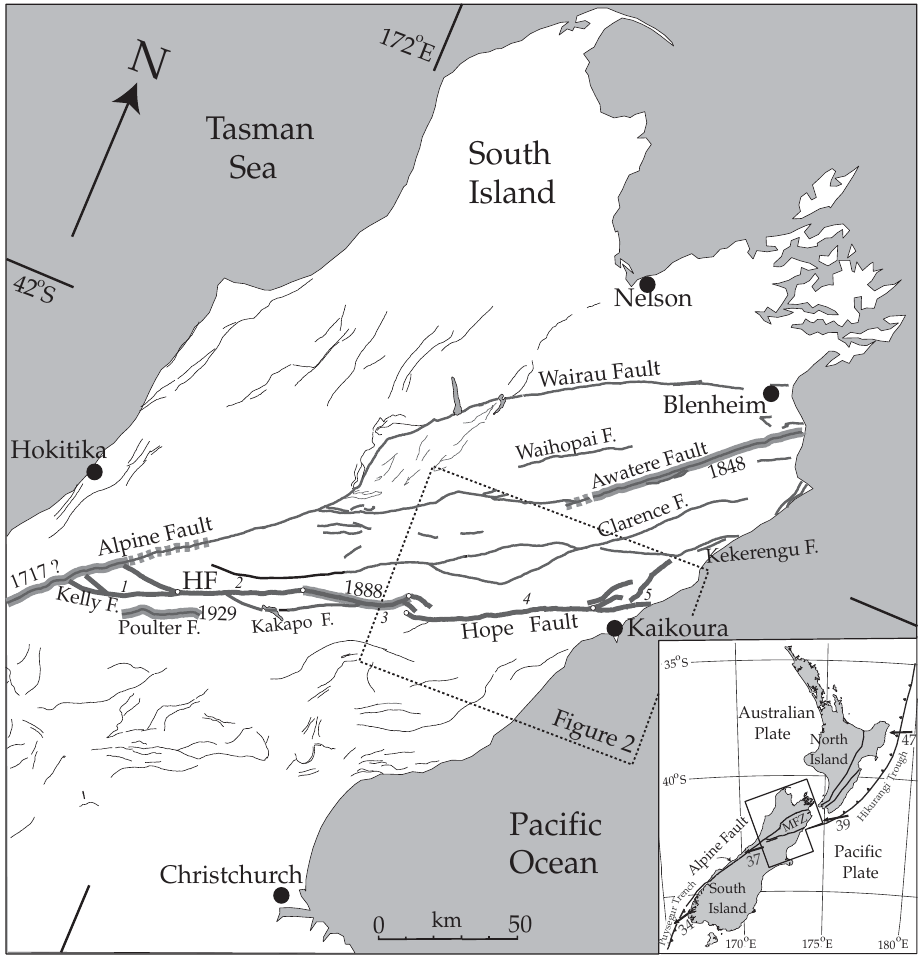
Fig. 1. Location of the Hope Fault in the Marlborough Fault Zone (MFZ) (bold lines), Northern South Island. The Hope Fault System is shown boldest and fault segments are numbered in italics (1 - Kelly Fault; 2 - Hurunui section; 3 - Hope River Segment; 4 - Conway Segment, and 5 - Seaward Segment), their boundaries being marked by open circles. Surface fault ruptures, e.g., 1888 North Canterbury earthquake, are shown as grey bands. Inset: New Zealand plate boundary including Alpine Fault, MFZ and Hikurangi Trough. Nuvel-1 directions (arrows) and plate rates relative to Australian Plate (in mm/yr) after DeMets et al.